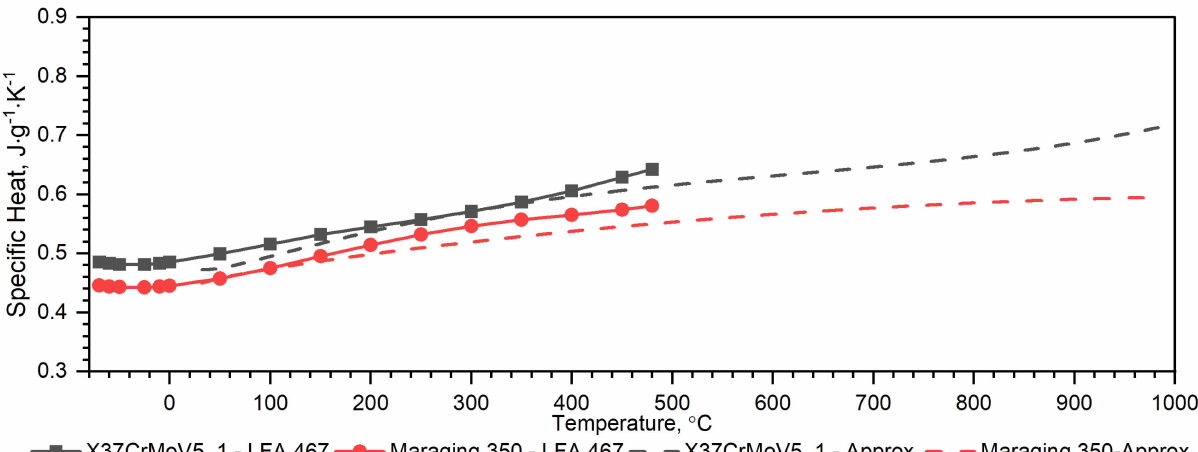
Figure 9. Specific heat as a function of temperature for the X37CrMoV5 − 1 hot-work tool steel and Maraging 350 steel obtained from the first heating run on LFA 467 in the range from − 50 ◦ C to 500 ◦ C and from the approximation of the experimental data on DSC in the range from RT to 1000 ◦